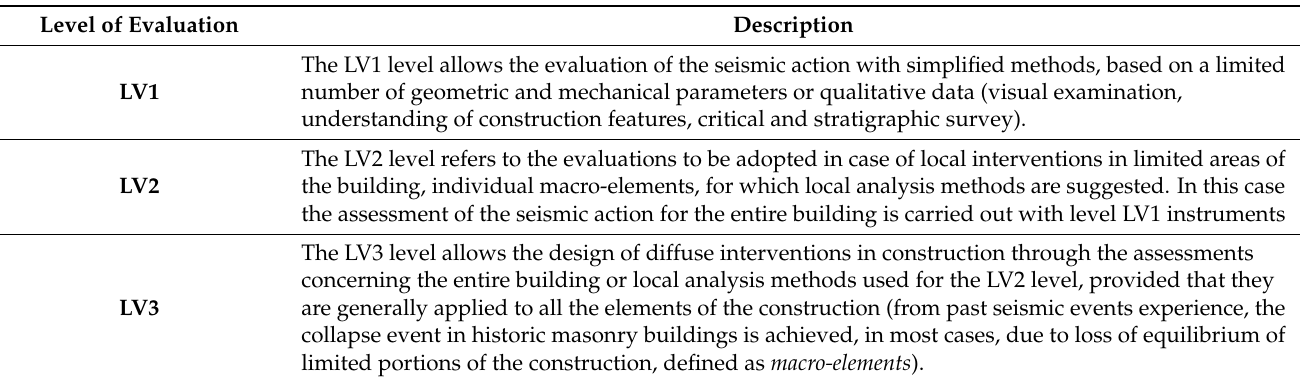
Table 2. Level of Evaluation method from Italian regulation (DPCM